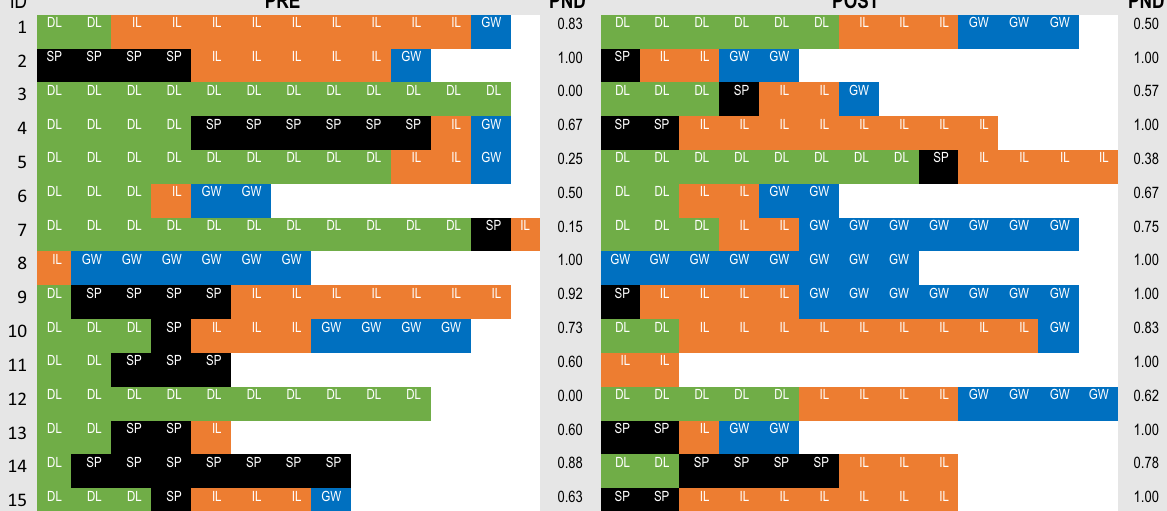
Didactic-Lecture, SP